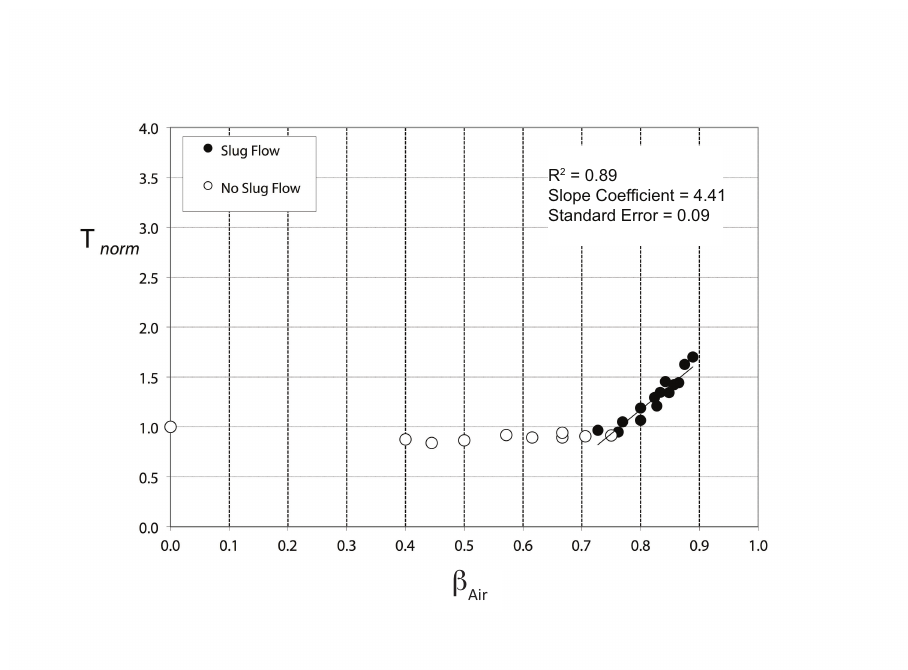
Figure 14. SFE L8D8 DST15 regression